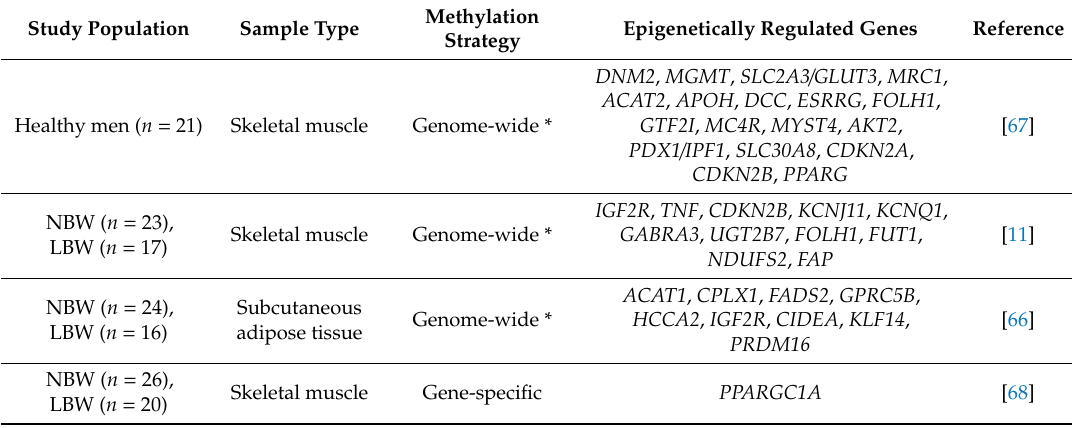
Table 2. E ff ects of a 5-day high-fat overfeeding diet on DNA methylation in humans.